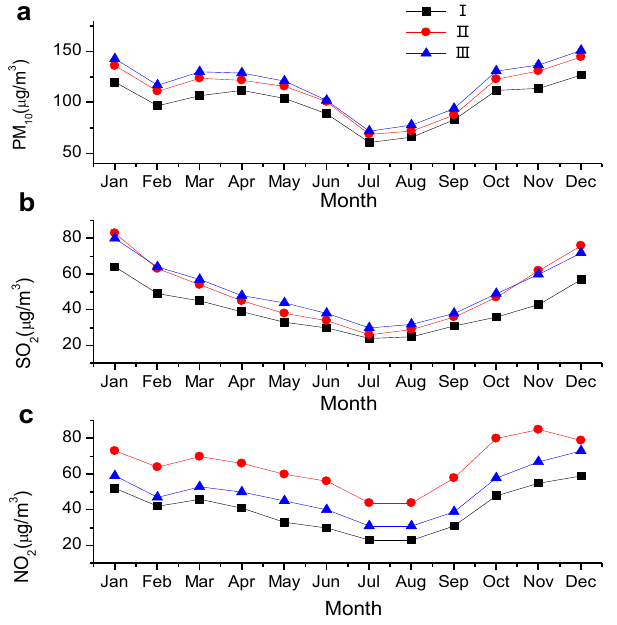
Figure 9. Monthly concentration averaged over monitoring sites within the same cluster. ( a ) PM 10 ; ( b ) SO 2 ; ( c ) NO 2 .